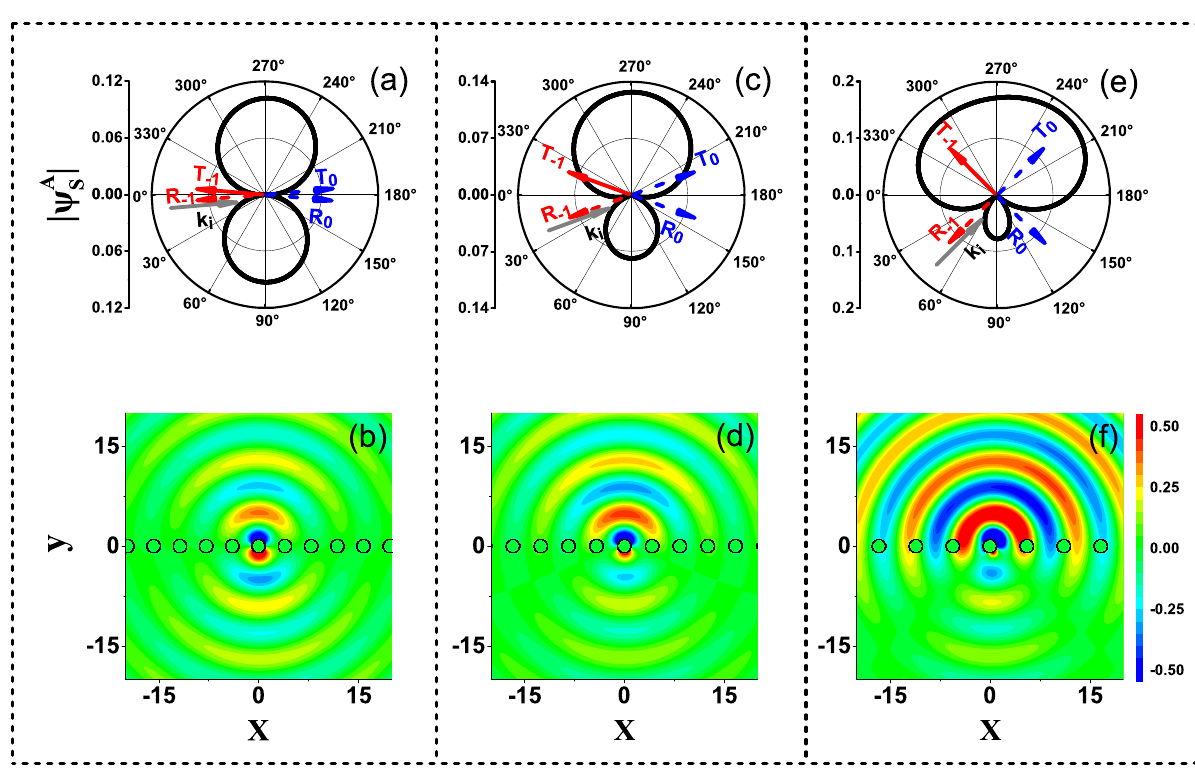
Fig. 4 Scattering from a QD in a linear array. a ∣ Re f ψ A around a circle with radius ρ = 60, and ( b ) Re f ψ A in a square region for θ WA = 5°. Re s gj s g g is the real part of the fi rst spinor component [see Eq. (2)] of the fi eld scattered by a QD located in the linear array. c , d [( e ) and ( f )] f ψ A s is zero, which leads to the disappearance of correspond to θ WA = 20° ( θ WA = 45°). In the ordinary and -1st-order re fl ection directions, Re f ψ A s g the two diffraction orders. This is also the case at θ WA = 5° (see Supplementary Fig. 1). The scattered fi elds are calculated for the QD located at the origin of the coordinates. The presence of many QDs in ( b ), ( d ) and ( f ) implies that inter-QD coupling has been